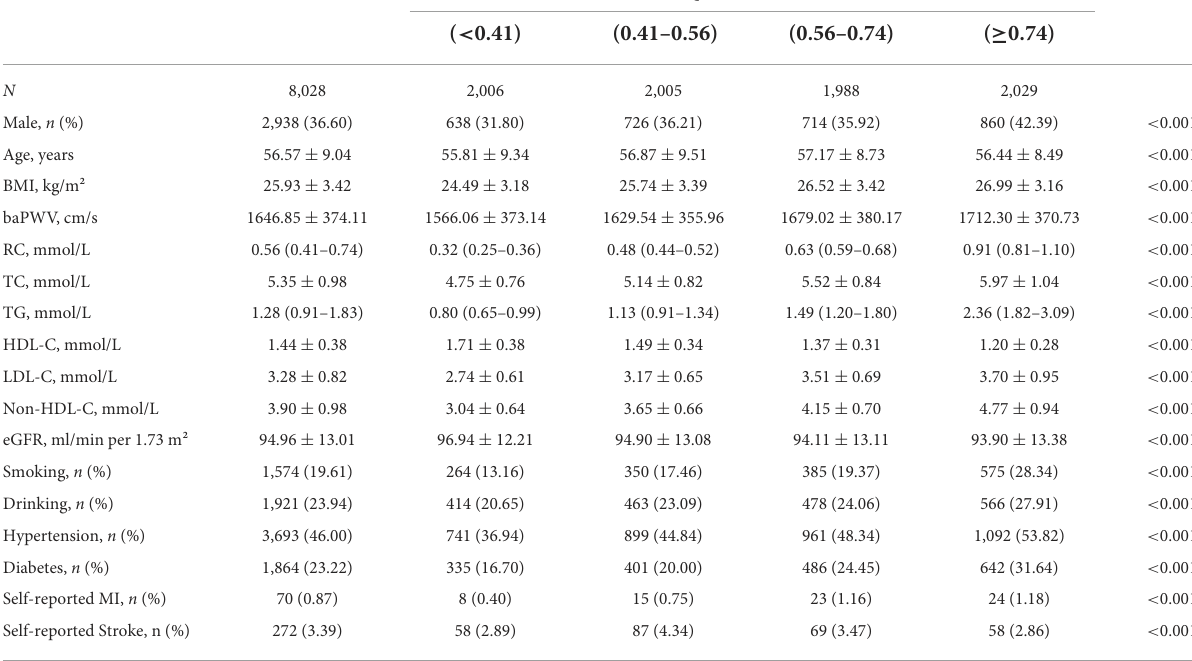
TABLE 1 Characteristics of the study